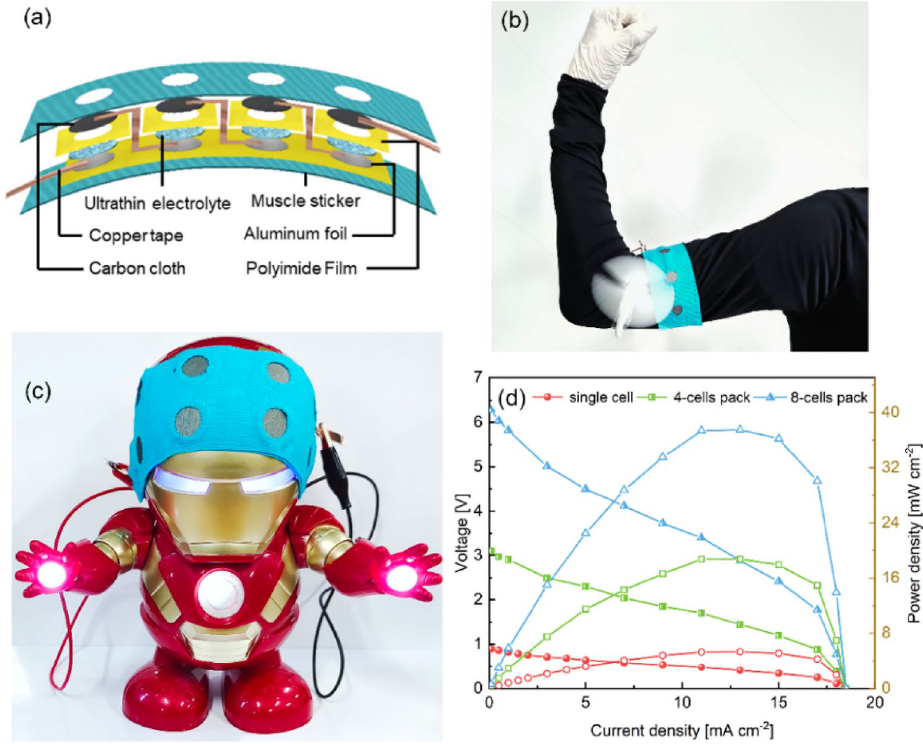
Figure 7. ( a ) Schematic diagram of the cell pack (Microsoft Office Hone and Student 2019-zh-cn https:// www. micro softs tore. com. cn/ softw are/ office). The digital images of the cell pack with 4 ( b , c ) 8 single cells power a small fan and the Iron Man toy, respectively. ( d ) The polarization curves and power-density profiles of the cell pack and single